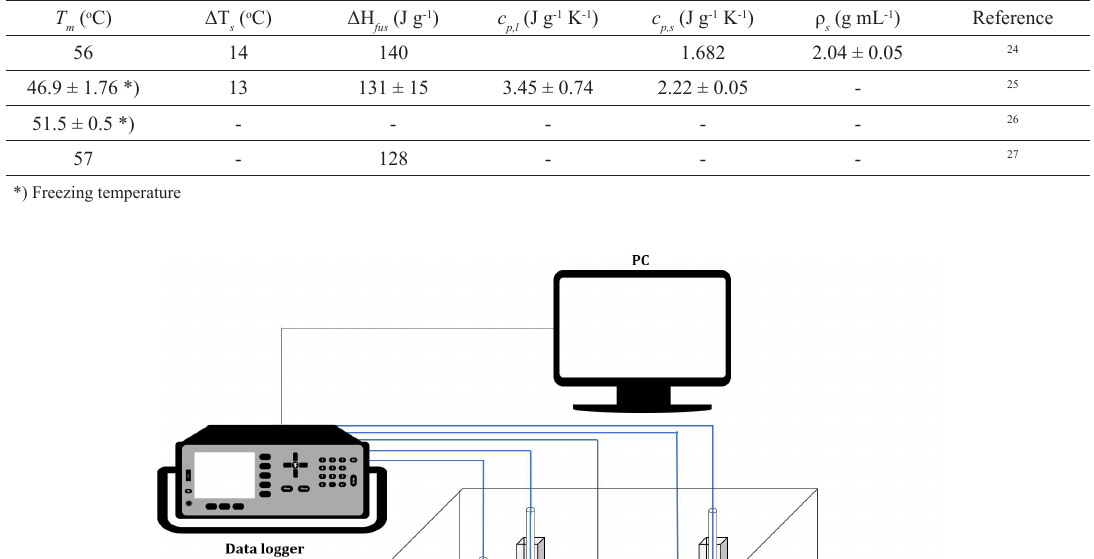
Table 1. Thermophysical properties of CoNHH from previous studies.